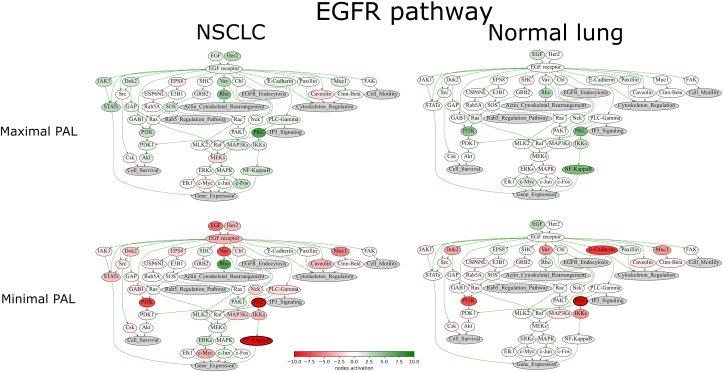
EGFR pathway (Qiagen Pathway Central) shown as an interacting network for samples with maximal (top) or minimal (bottom) PAL in colorectal cancer (left) vs normal colon (right). Green/red arrows indicate activation/inhibition interactions, respectively. The color depth of transcript nodes reflects the extent of node activation (logarithms of the expression fold change for each node, the reference is the geometric average between expression levels in all samples in the respective groups). Visualized using Oncobox software.